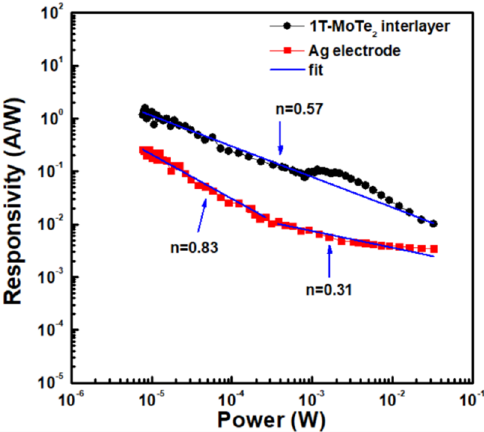
Figure 3. The photoresponsivity plotted with respect to illumination intensity for 2H-MoTe 2 using Ag and 1T-MoTe 2 interlayer electrode contacts.